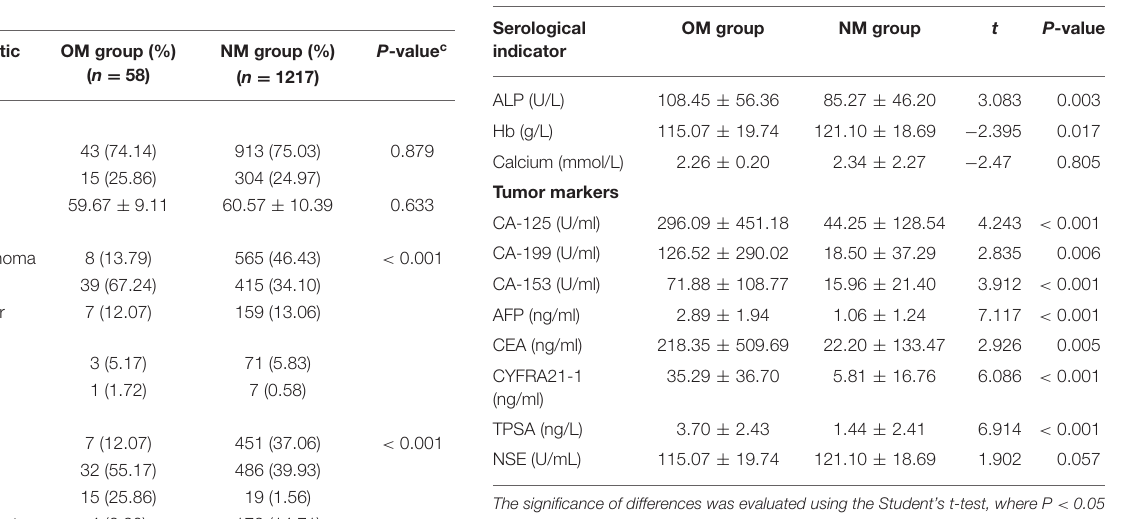
TABLE 2 | Serological indicators of ocular metastasis of lung